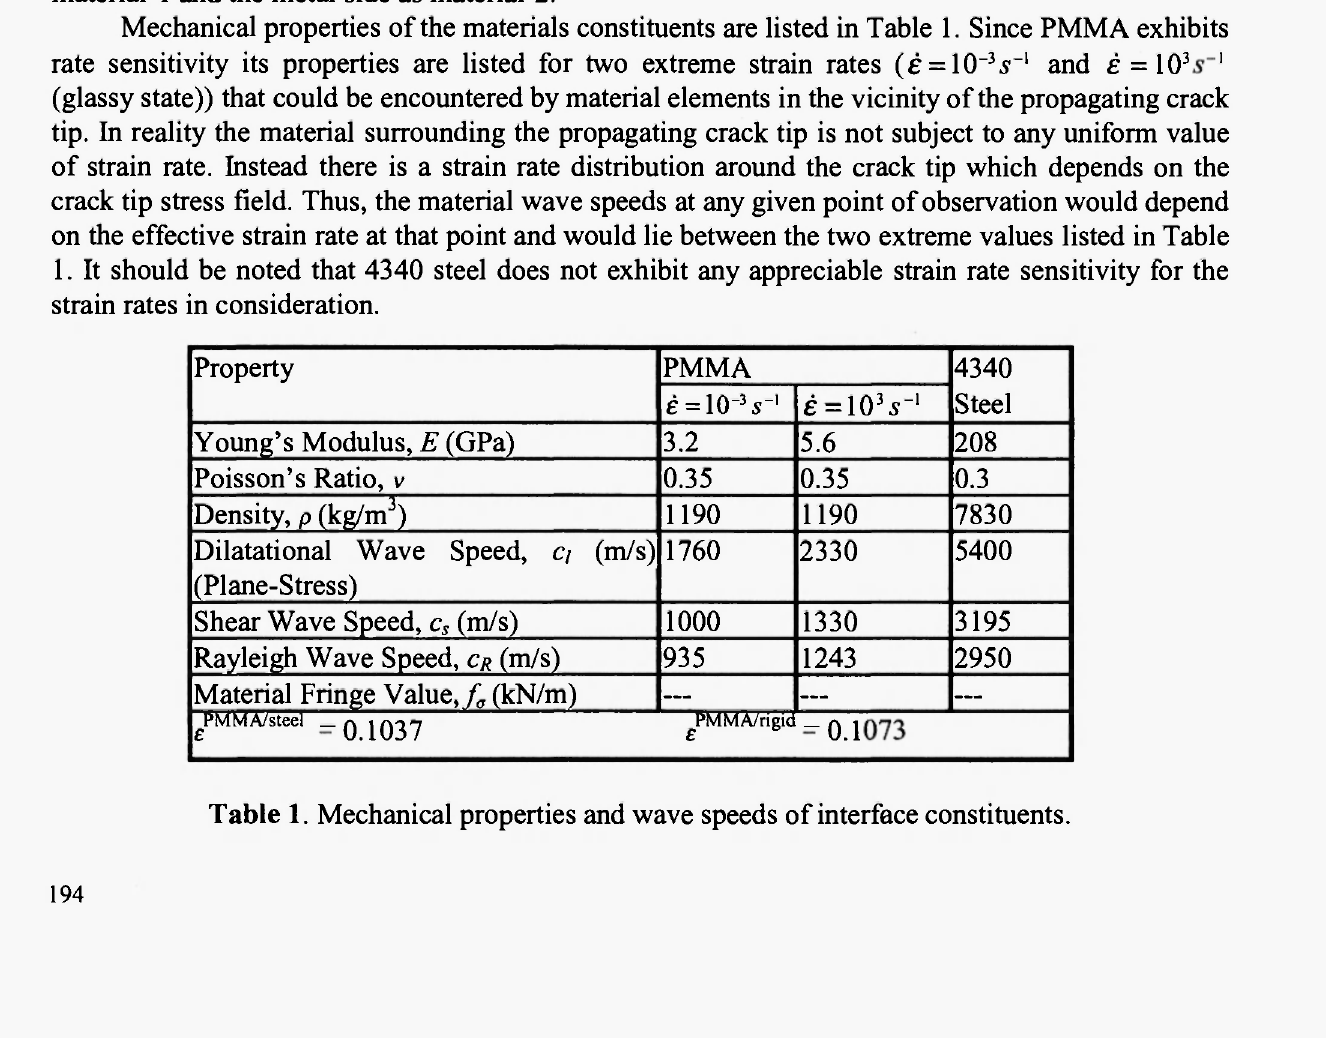
Table 1. Mechanical properties and wave speeds of interface